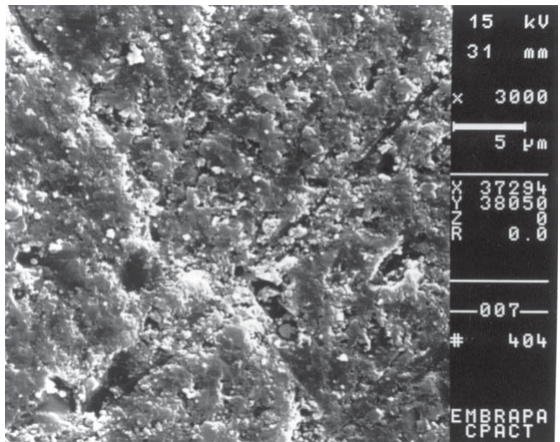
Figure 5. SEM micrography of Belleglass surface at aging time 0 (SEM original magnification 10000 × ).